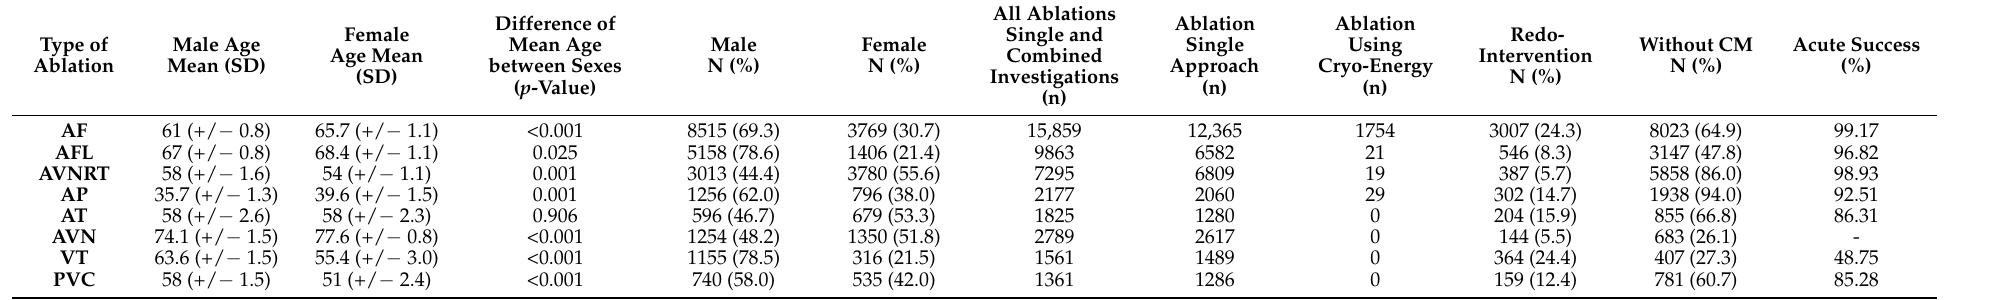
Table 2. Baseline characteristics: Catheter ablation for various arrhythmias (2013–2019